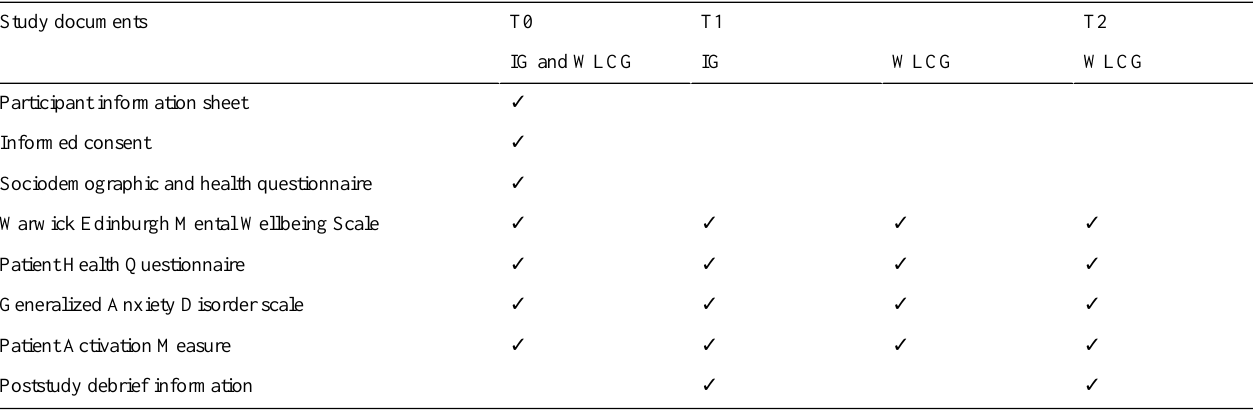
Table 1. Information and questionnaires presented to IG and WLCG participants at each time point (T0, T1, and T2), across the duration of the study. a